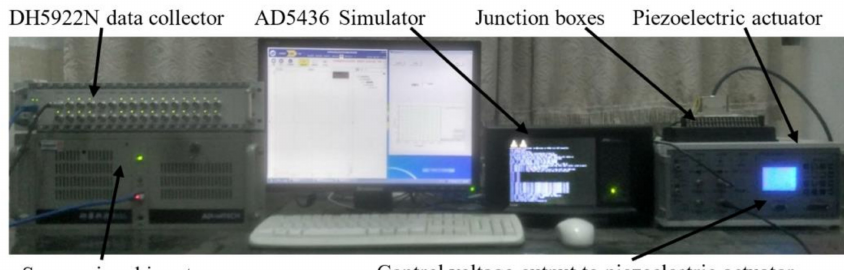
Figure 10. Shafting test bench.